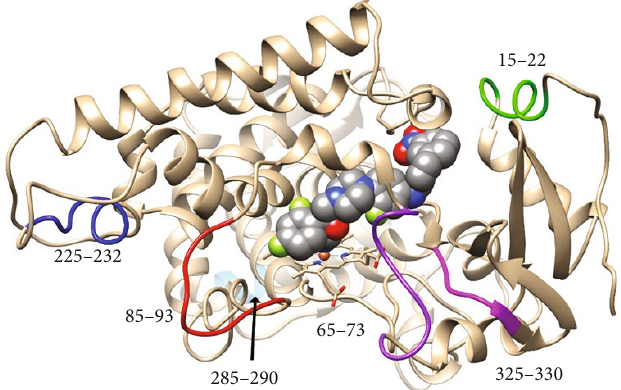
Figure 10: Illustration the location of the RMSF change by colored